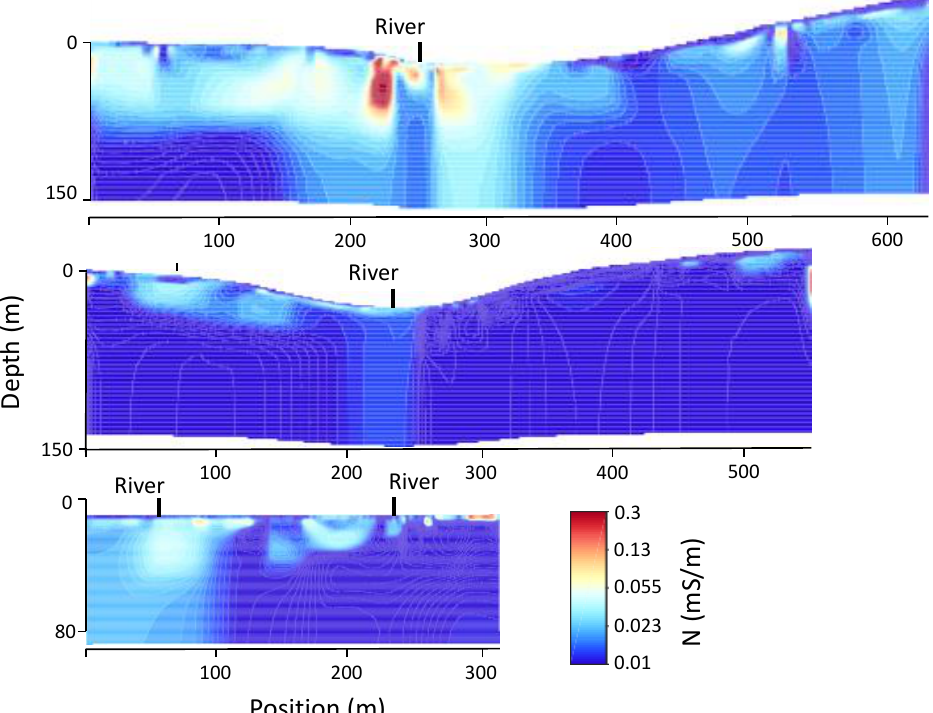
Figure A3. Normalized chargeability distributions. Up: Profile 1, Middle: additional profile perpendicular to the river and Down: additional profile globally parallel to the river, which crosses the river in two